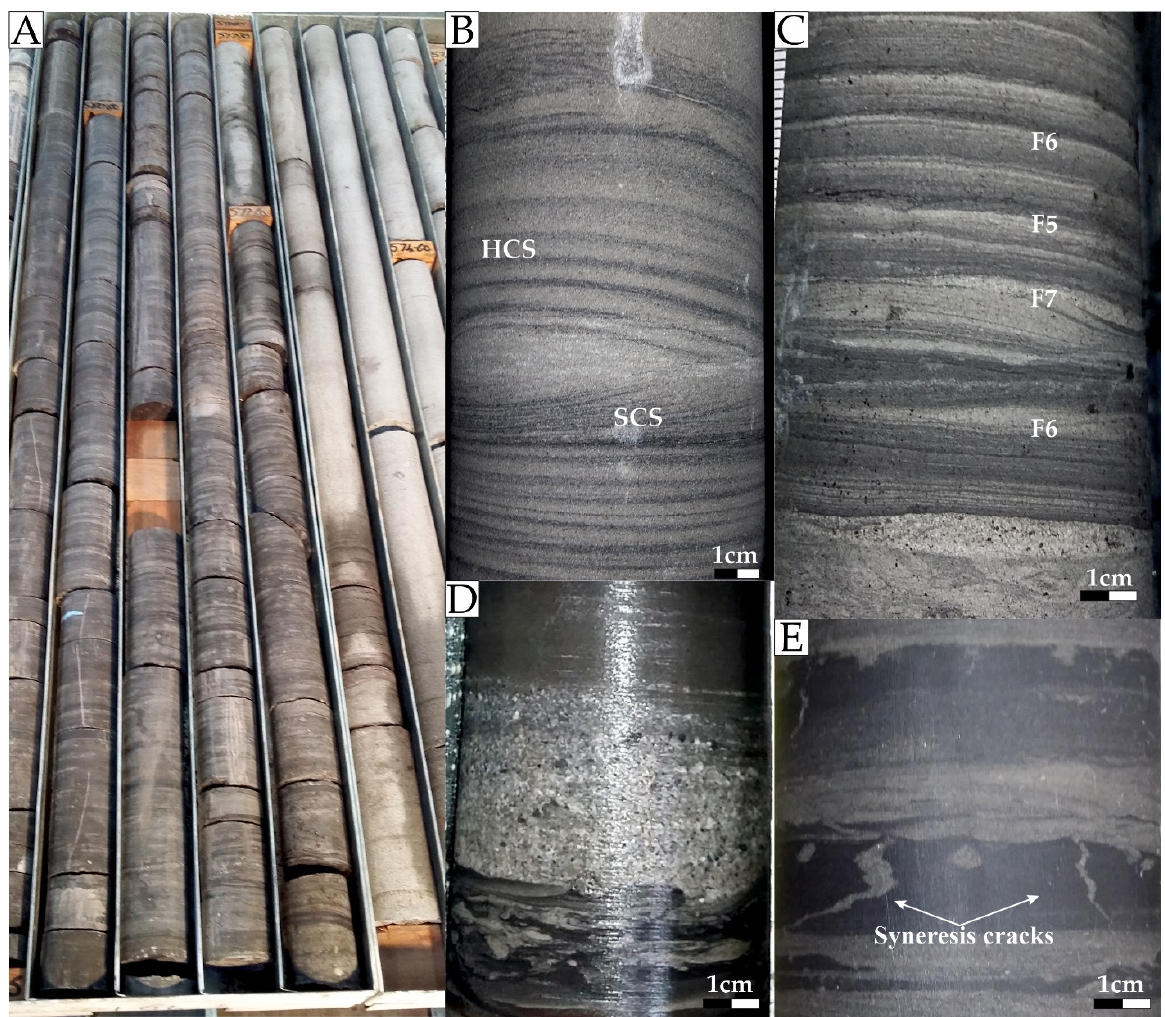
Figure 8. Core photographs illustrating sedimentological characteristics of the FA7 (prodelta). ( A ) Prodelta deposits that are overlain by delta-front deposits (FA6). ( B ) SCS-sandstone that is overlain by HCS-sandstone documenting the impact of storm currents during sedimentation. ( C ) Repetitions ripple cross-laminated sandstone and mudstone with parallel and structureless mudstone, forming heterolithic bedding. Note the presence of mud drapes in ripple cross-laminated sandstone intervals that indicate the tidal impact on sedimentation. ( D ) Storm-related coarse grained, pebbly deposits (tempestites) intecalated with mudstone. ( E ) Syneresis cracks in prodelta deposits.